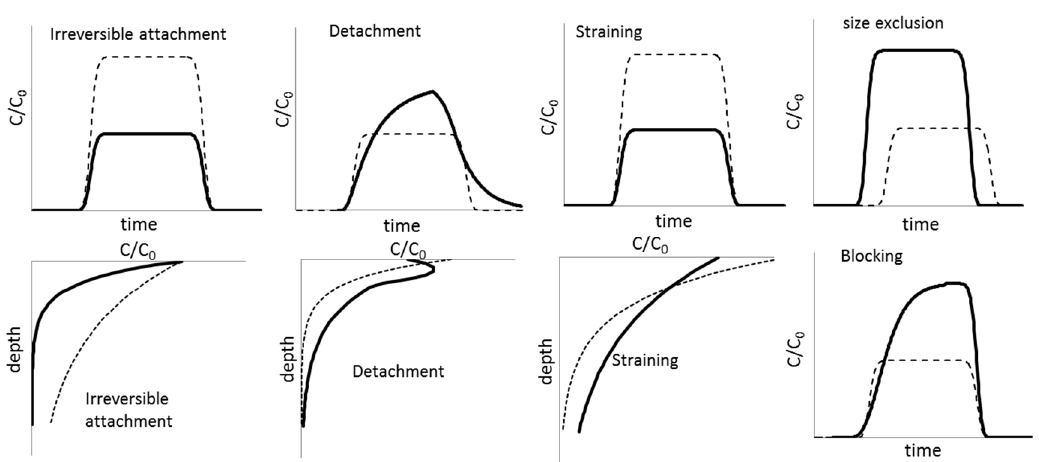
Figure 6. Schematic representations of hypothetical breakthrough curves (column outflow concentrations as a function of time) or depth profiles (solid concentrations as a function of depth). Full lines show how an enhancement of the proposed mechanism could affect results relative to a reference situation where only irreversible attachment occurs in dotted lines, see further [38].